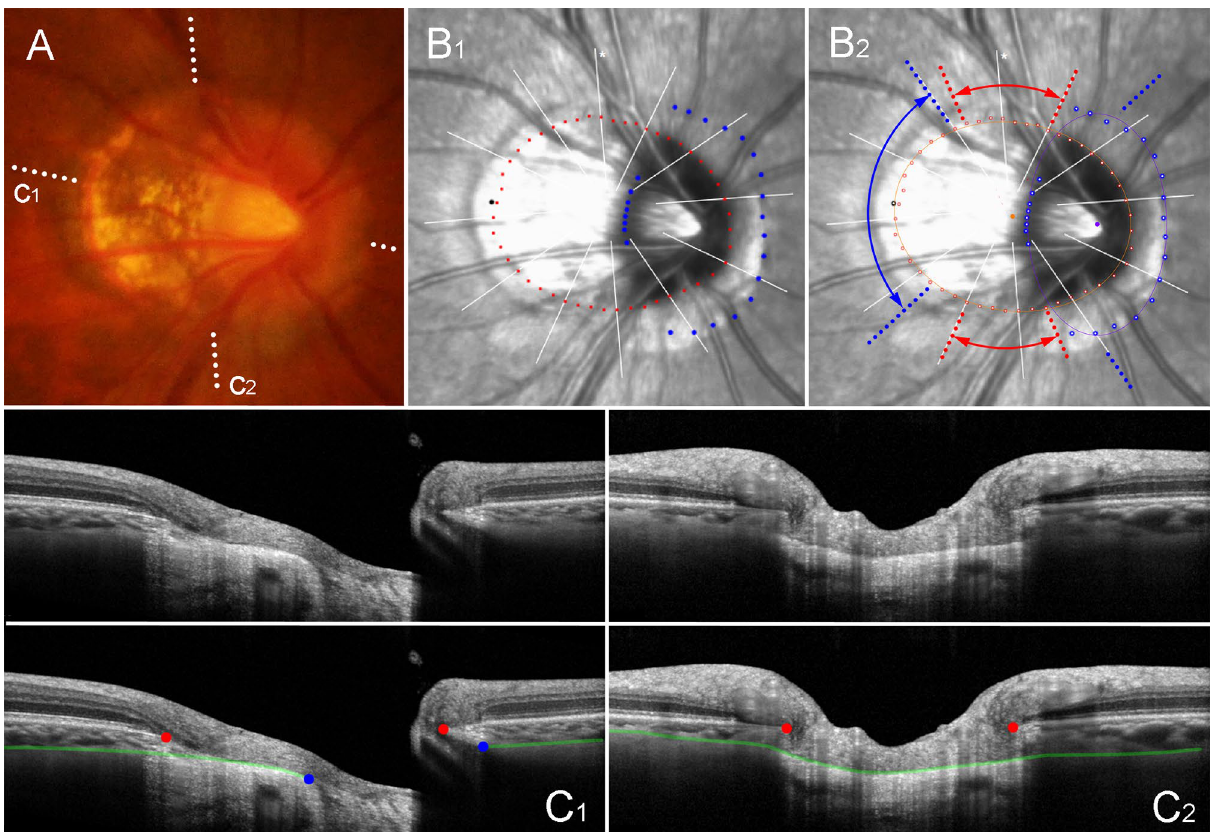
Figure 8. Critical disadvantage of determining anterior scleral opening (ASCO) based on radial scans centered on Bruch’s membrane opening (BMO) (right eye of 55 year-old-man without glaucoma, axial length of 25.50 mm). ( A ) Disc photograph. The dotted lines indicate the location of the OCT scan. ( B ) Infrared images. ( B 1 ) Bruch’s membrane opening (BMO, red dots), anterior scleral opening (ASCO, blue dots), and meridian of longest externally oblique border (EOB, black dot) are marked. ( B 2 ) Best-fitted ellipses for BMO (orange ellipse) and ASCO (purple ellipse) are drawn with their centers (orange dot for BMO center, purple dot for ASCO center). ( C ) B-scan OCT images. (top row: original images, bottom row: images with labels). The red dots indicate the BMO margin; the blue dots indicate the ASCO margin; the green lines indicate the anterior scleral surface. Please note that the B-scans between the red-dotted lines ( B 2 ) cannot yield any information about the ASCO, because they simply cannot capture the optic nerve canal at all ( C 2 ). Also, the B-scans between the blue-dotted lines ( B 2 ) produce uneven sampling for the ASCO: the ASCO margin closer to the BMO center (orange dot) is clustered within a very limited range ( B 2 ). Therefore, the ASCO itself is largely influenced by the ASCO/BMO offset, because no radial scans can focus on two different centers simultaneously. In this context, the ASCO/BMO offset as defined by BMO-oriented radial scans has irreparable